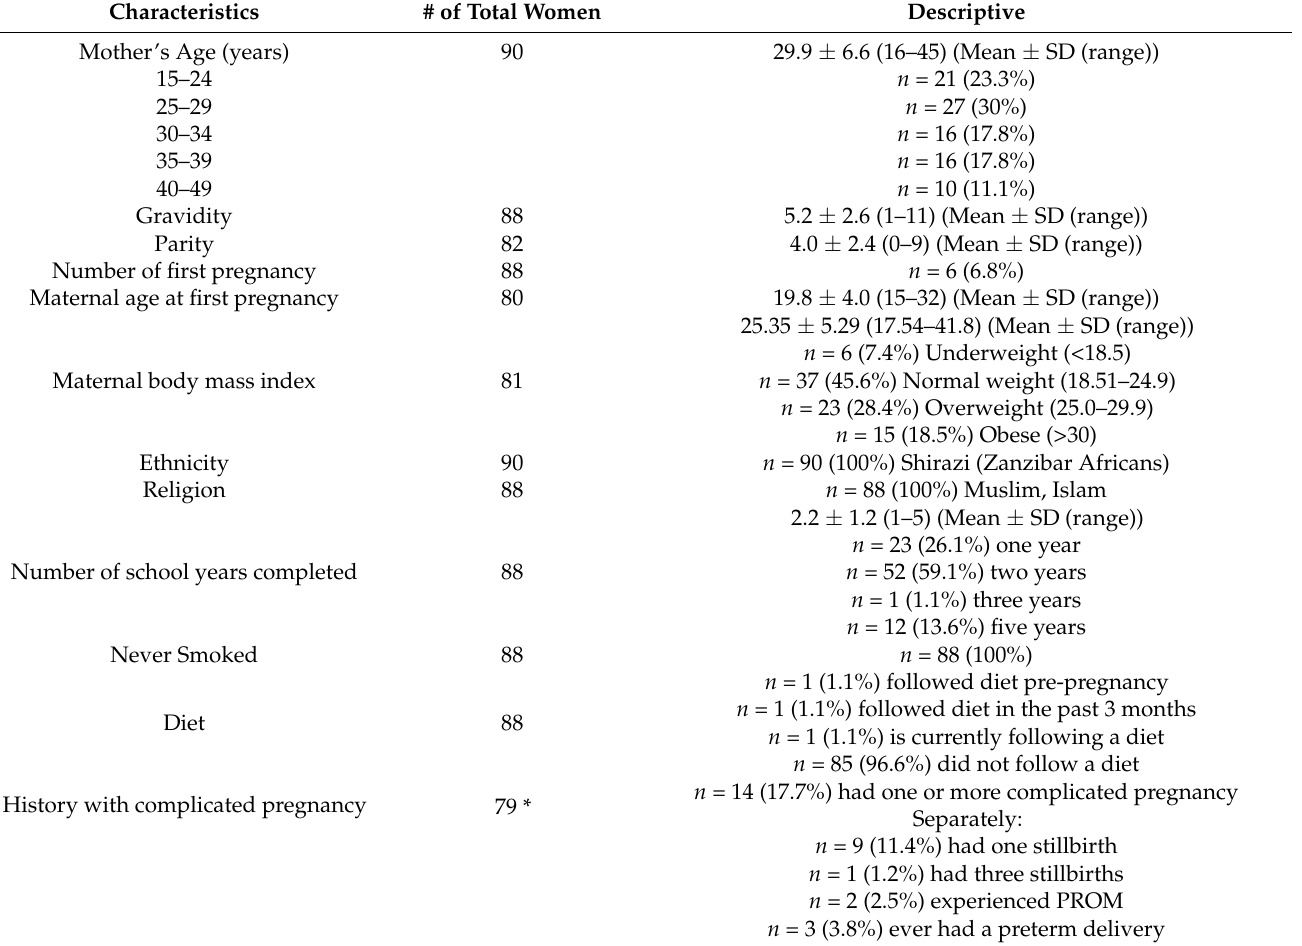
Table 1. Description of the sociodemographic, clinical and pregnancy outcomes across cohort.